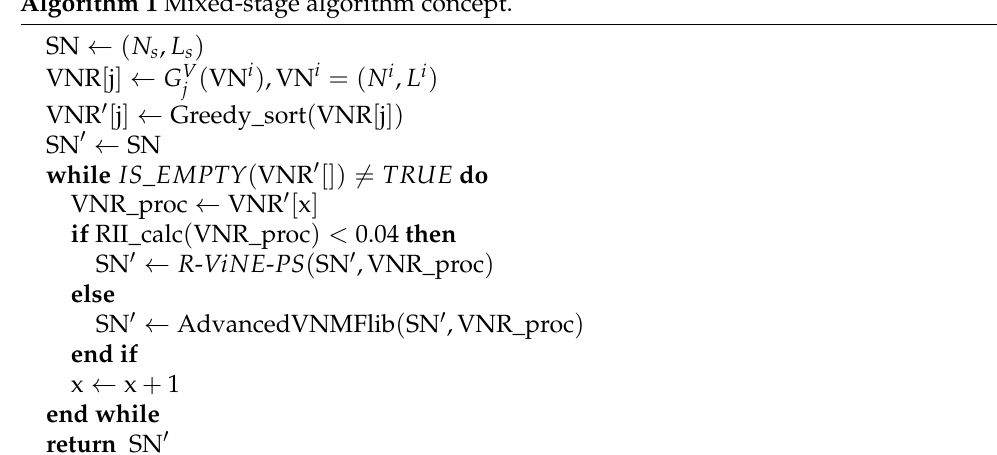
Algorithm 1 Mixed-stage algorithm